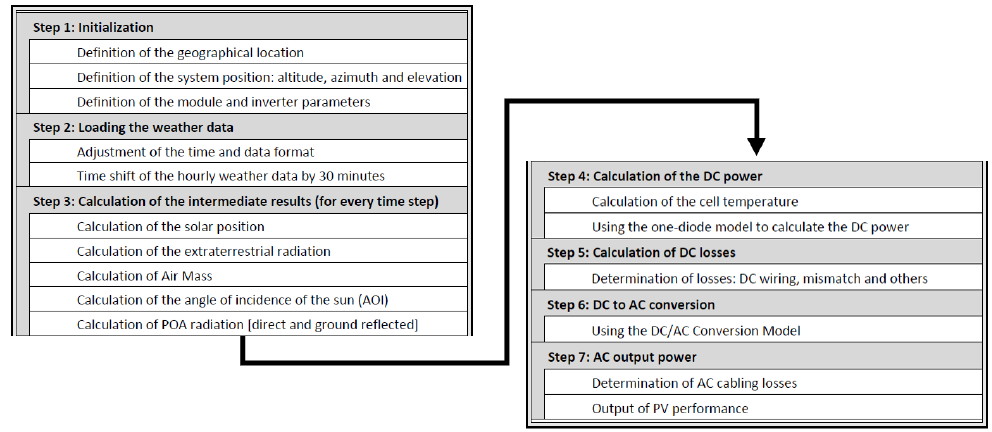
Figure 2. Schematic diagram of the modeling chain for yield simulation of a photovoltaic system using pvlib according to Gurupira and Rix